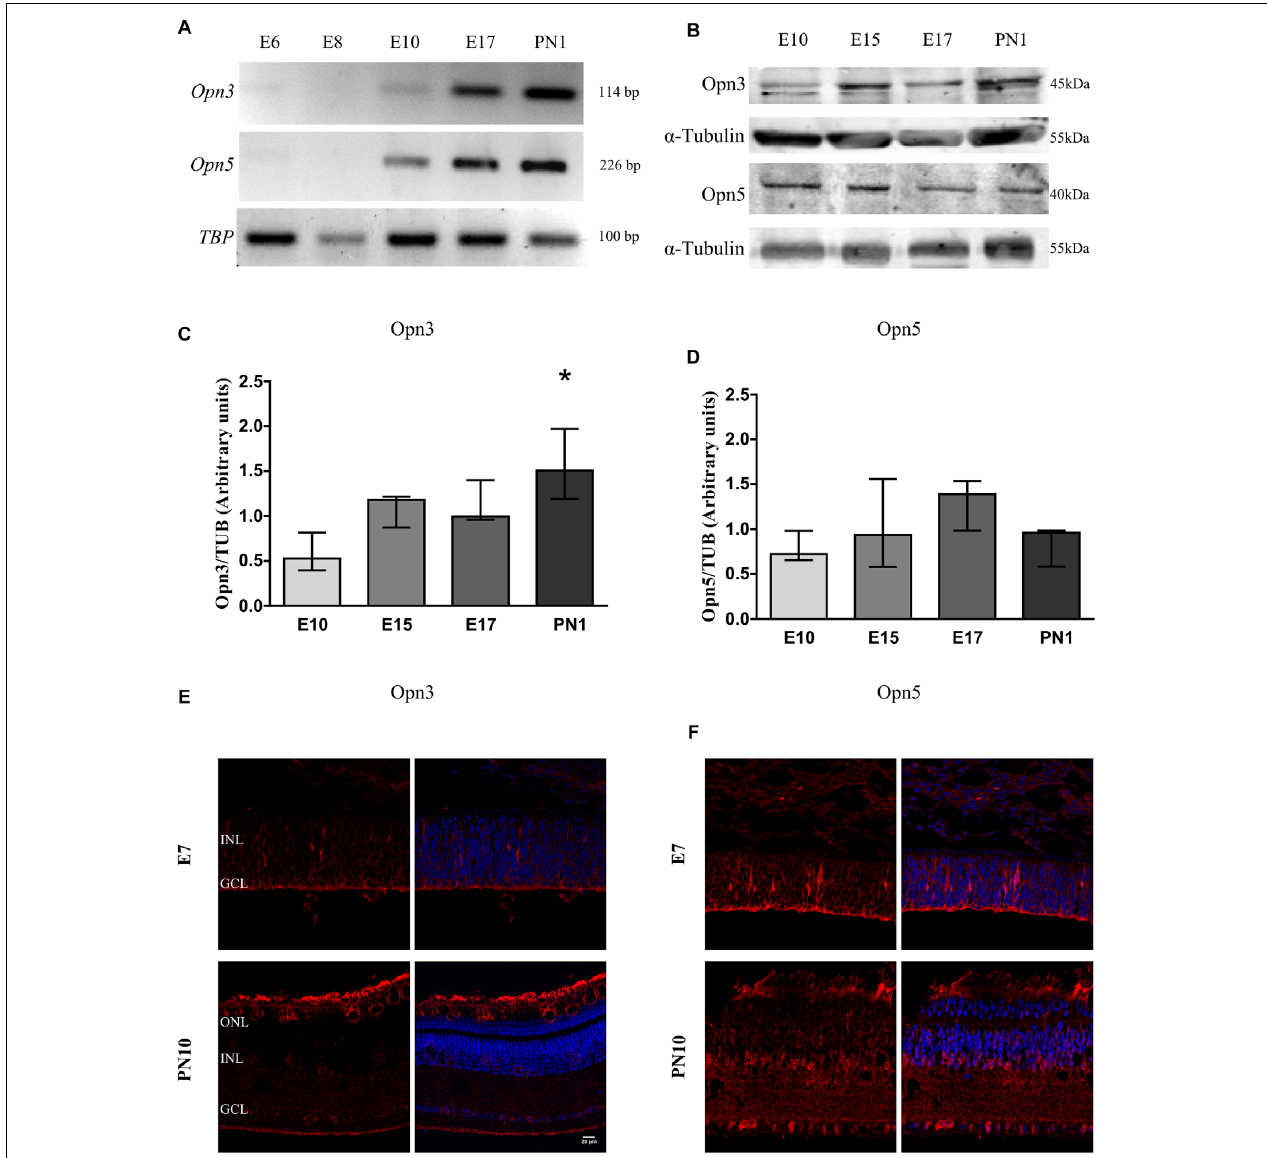
FIGURE 1 | Temporal profiles of Opn3 and Opn5 expression in the developing chicken retina. (A) Analysis of Opn3 and Opn5 mRNA expression (with TBP as housekeeping gene) in the whole chicken retina from embryonic day 6 (E6) to post-natal day 1 (PN1). (B–D) Analysis of protein expression of Opn3 and Opn5 in the whole chicken retina from E10 to PN1 by WB. (B) Immunoblots show two bands of ∼ 43–45 kDa for Opn3 protein, whereas a single band was observed at ∼ 40 kDa for Opn5 protein. (C) The histogram shows the median with range for Opn3 levels in the whole chicken retina from E10 to PN1. The K–W test revealed a significant effect of developmental stage [ H ( 3 ) = 8.13, ∗ p < 0.05], ∗ Values at PN1 differ from those at E10 stage ( n = 3/group). (D) The graph shows the median with range for Opn5 levels in the whole chicken retina from E10 to PN1. The K–W test revealed no significant effect of development [ H ( 3 ) = 3.97, p > 0.05 ( n = 3/group)].